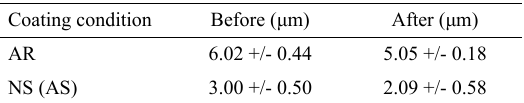
Figure 5. Erosion-oxidation test results of samples coated with C -25(Ni20Cr) powders. Tests were carried out for AR and NS Cr 3 2 5 hours at 25, 450, 700 and 800 ºC and erodent velocities of 10 and 19 m/s. Overall, 92 samples were tested and under each set of conditions, at least 4 samples. Note the improved performance of the NS coatings at the different temperatures, and especially